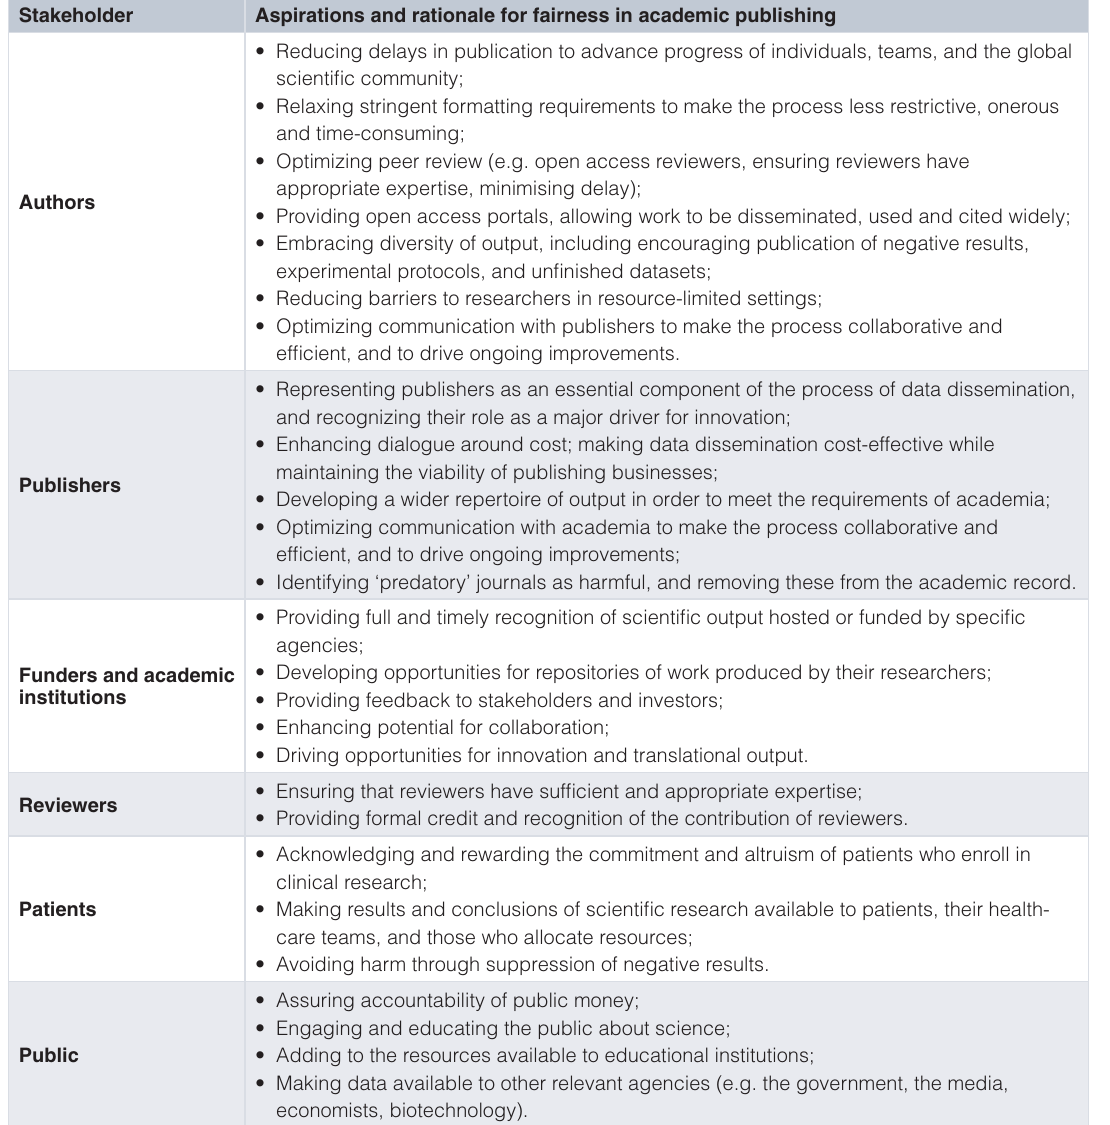
Table 1. How and why we should strive for fairness in academic publication on behalf of a variety of